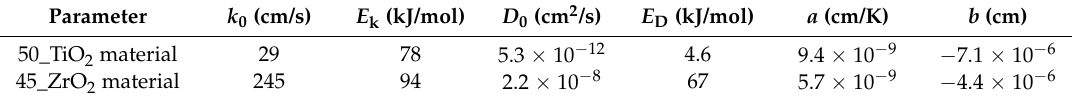
Figure 7. The relation curves of ( a ) ln k versus 1/ T , ( b ) ln D s versus 1/ T , and ( c ) h c versus T . Table 1. Values of the kinetic parameters for the oxidation of Cu-based oxygen carrier.